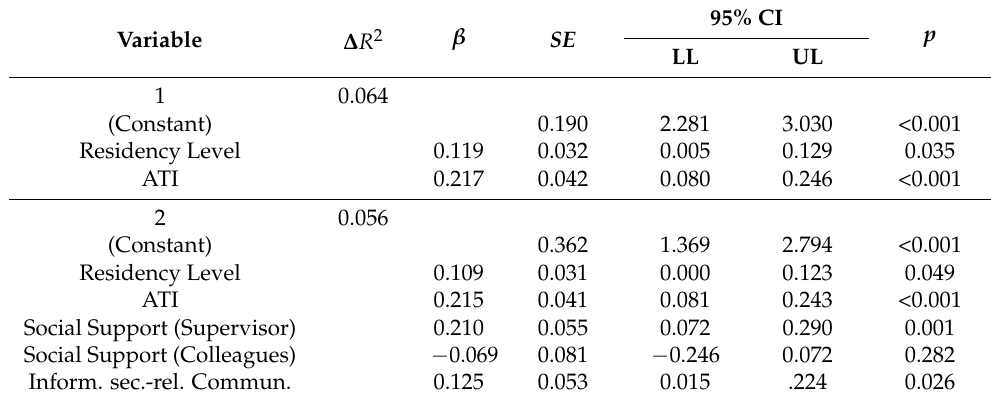
Table 2. Hierarchical Regression Analysis to predict security-related behavior (App